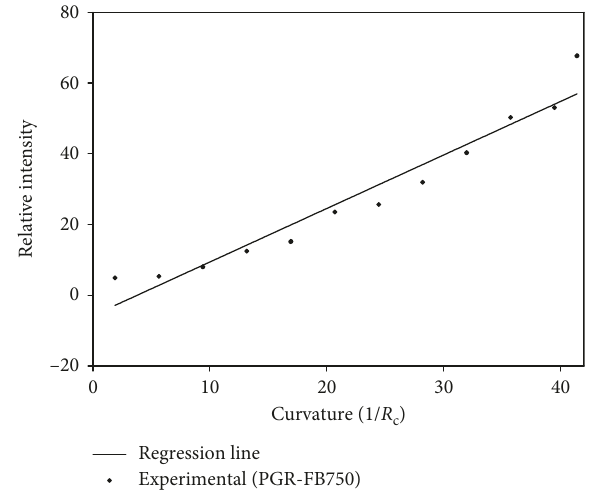
Figure 15: Effect of curvature on single POF side-illumination relative intensity.